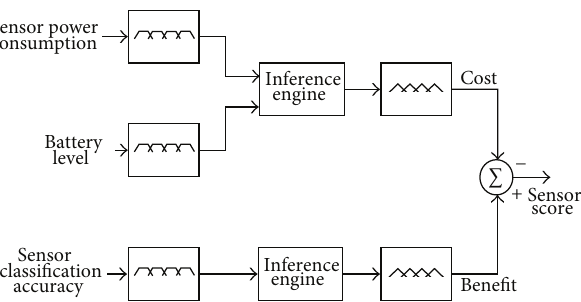
Figure 4: Wake-up algorithm uses initial classification to select tracking